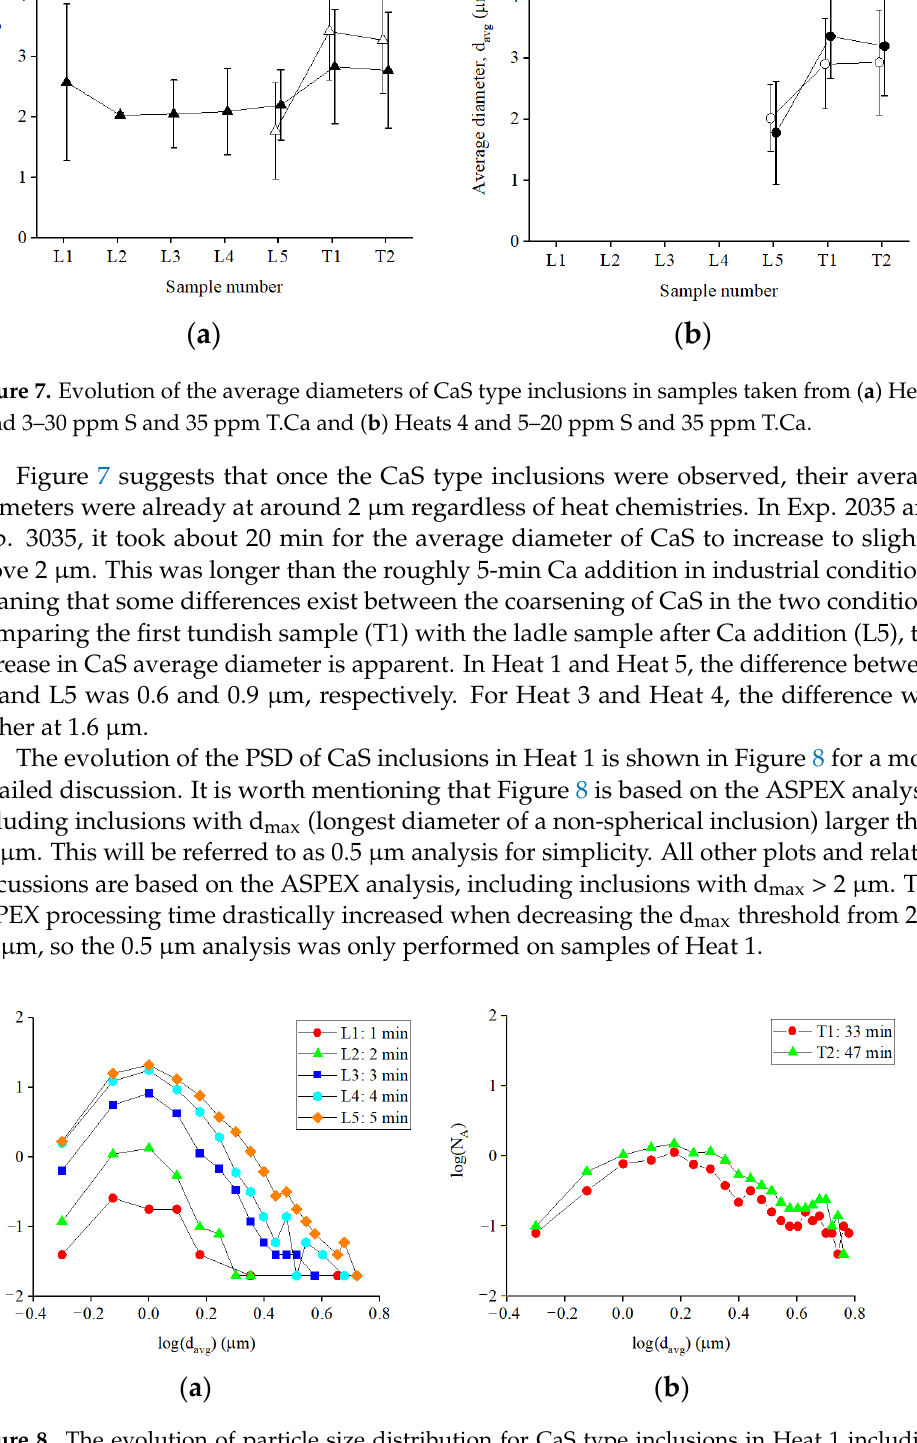
Figure 8. The evolution of particle size distribution for CaS type inclusions in Heat 1 including inclusions with d max > 0.5 μ m ( a ) ladle samples and ( b ) tundish samples.